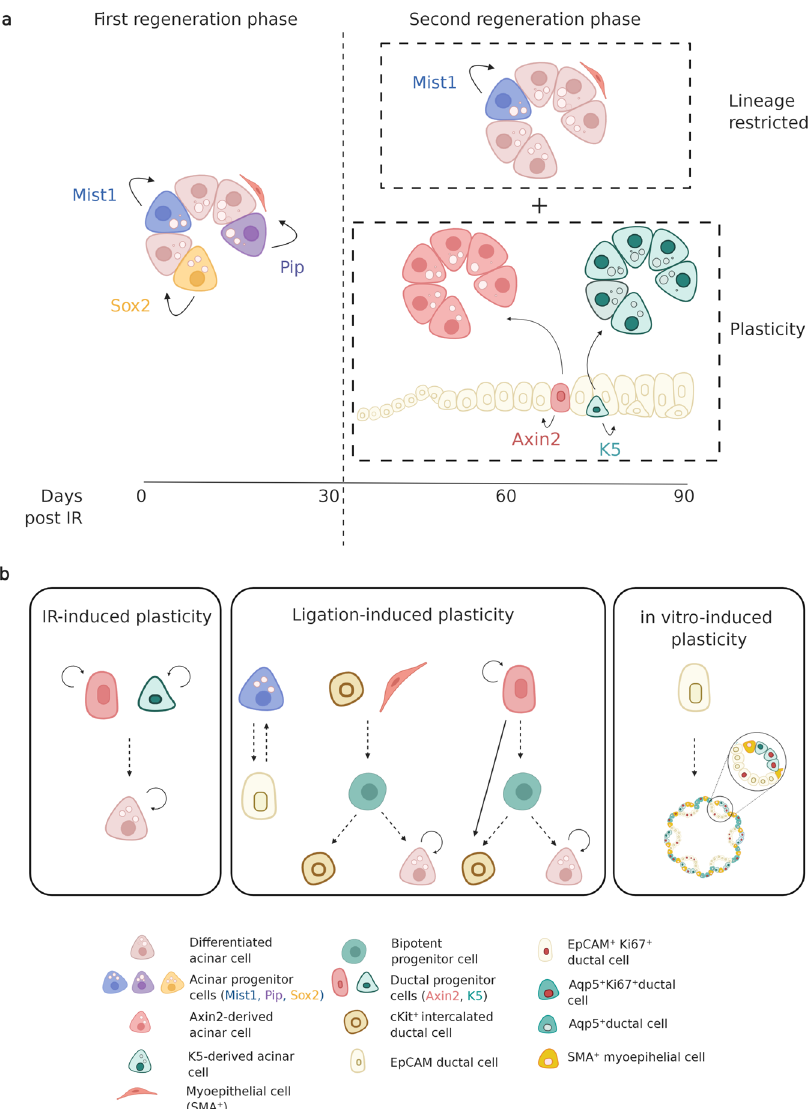
Fig. 4 Mechanisms of plasticity after damage in salivary glands. a Salivary gland regeneration phases after radiation-induced damage. Upon radiation damage, a fi rst regeneration phase seems to be characterized by a lineage-restricted response de fi ned by the self-duplication ability of acinar cells (Mist1 and Pip) into acinar cells as well as the replacement of acinar cells driven by immature acinar progenitor-like cells (Sox2) that within the fi rst 30 days post-irradiation are able to maintain the integrity of the acinar cell compartment. The second regeneration phase, marked by an extensive loss of acinar cells, seems to rely on the plasticity properties of the ductal cells (Axin2 and K5) that are able to give rise to new acinar cells. b In the context of tissue damage, salivary gland progenitor cells exhibit plasticity. Depending on the type of injury in fl icted, salivary gland cells show different damage-induced plasticity: irradiation-induced plasticity, ligation-induced plasticity, and in vitro induced plasticity (giving rise to an organized 3D system formed by different cell types named organoid) (Figure created with